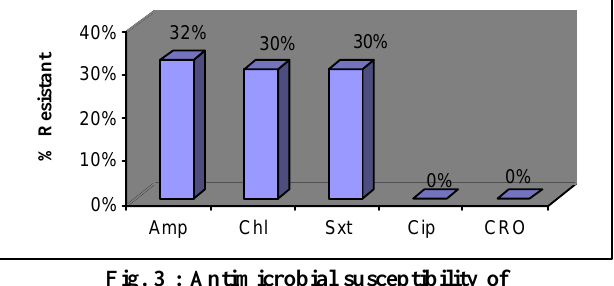
Fig. 3 : Antimicrobial susceptibility of Salmonella isolated in 2002